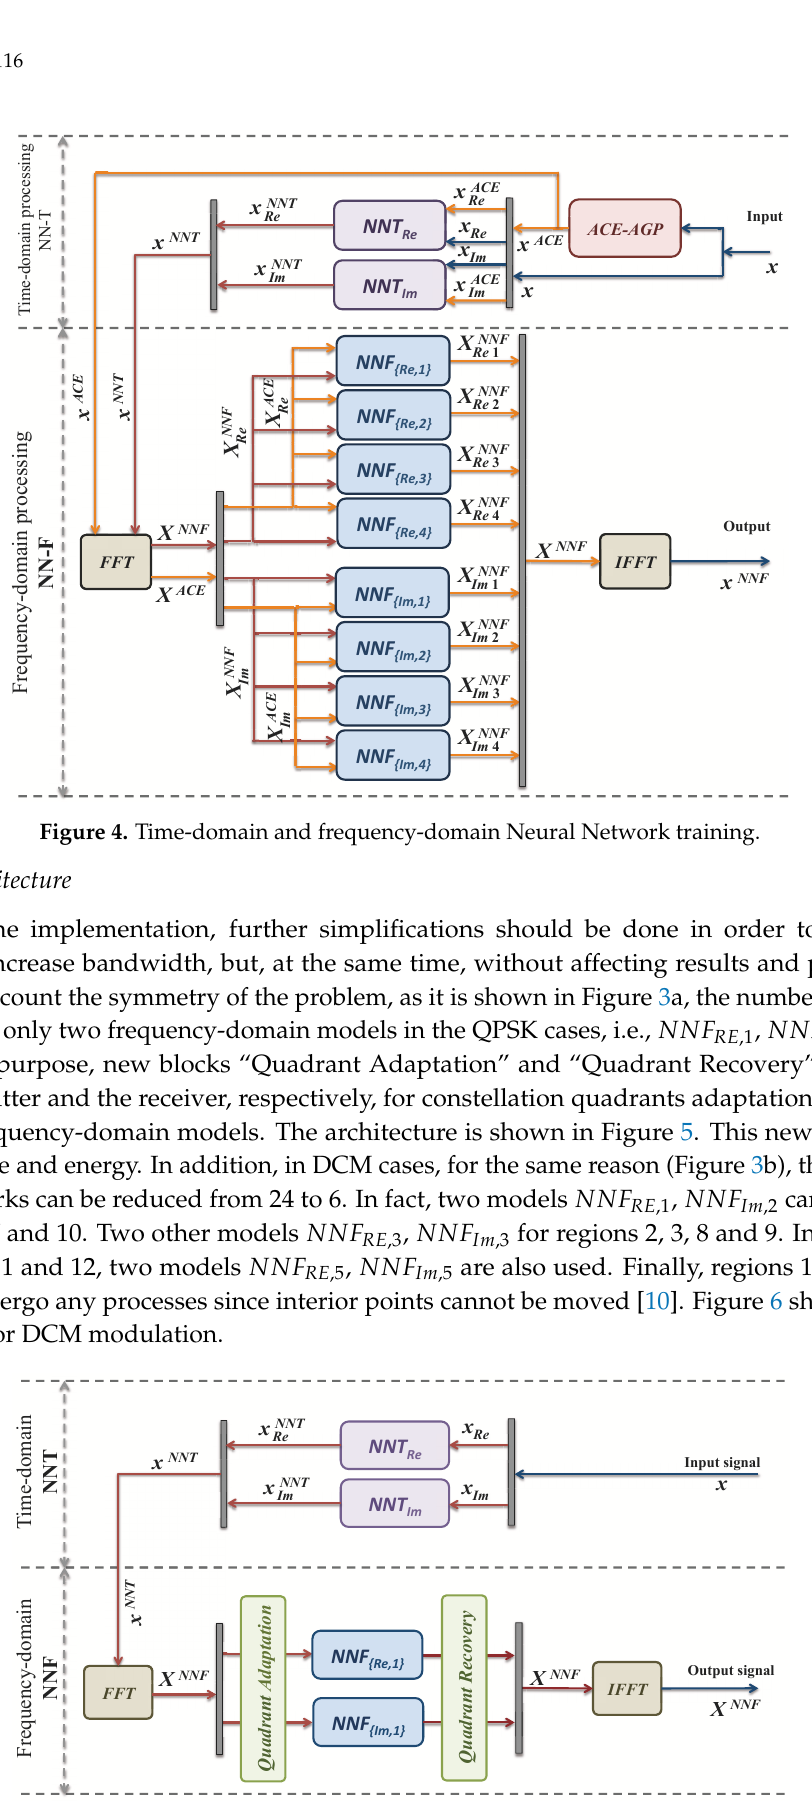
Figure 5. New time-domain and frequency-domain NN for